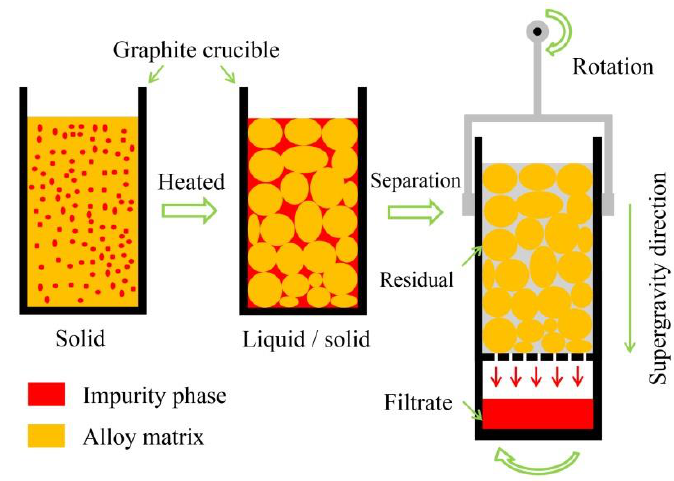
Figure 12. Schematic diagram of the super-gravity aided rheorefining process in this work.